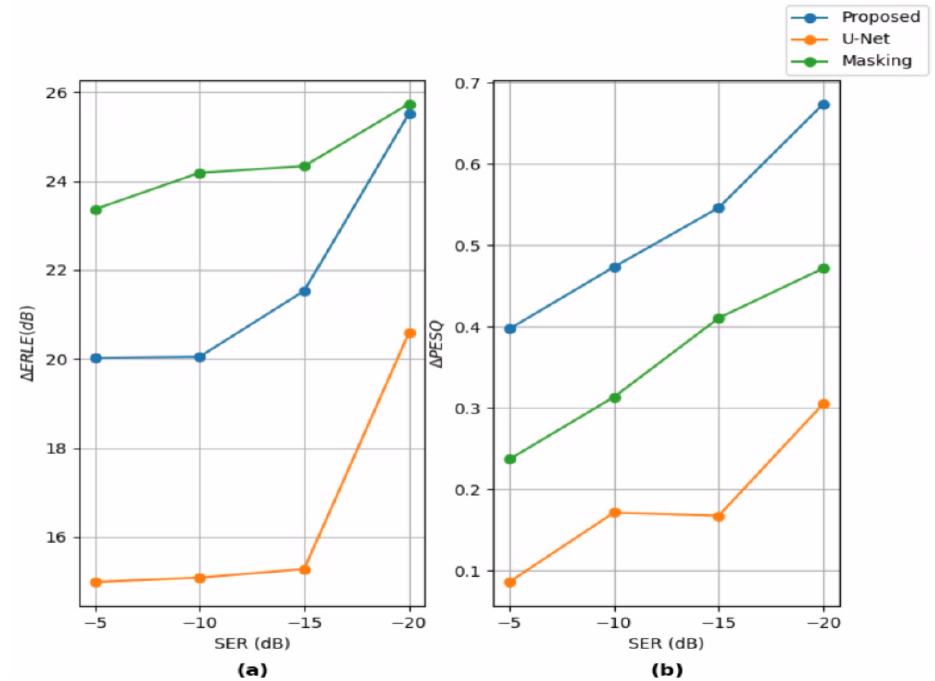
Figure 6. Systems’ performance in different SERs. ( a ) Echo return loss enhancement (ERLE) difference between the systems’ outputs and the error signal. ( b ) Perceptual evaluation of speech quality (PESQ) difference between the systems’ outputs and the error signal.